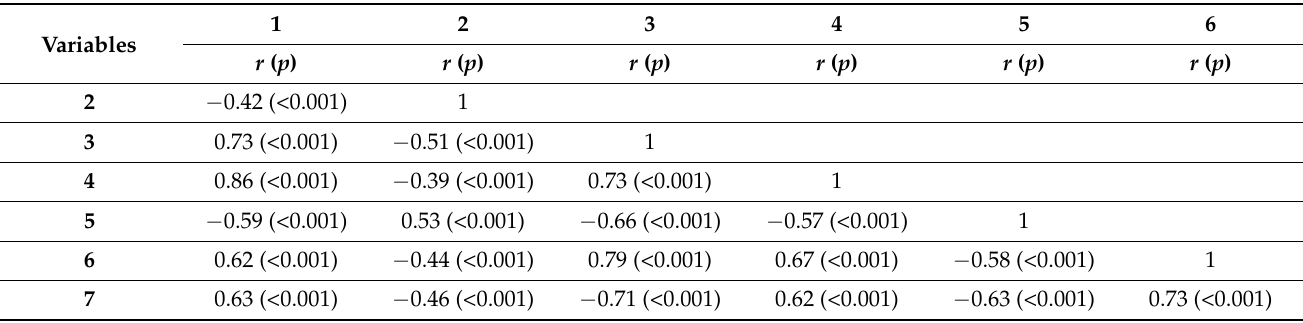
Table 2. Correlations among occupational stress, adaptive cognitive emotion regulation, maladaptive cognitive emotion regulation, experience with aggressive behavior in the workplace, compassion satisfaction, compassion fatigue and burnout in community mental health professionals ( N =